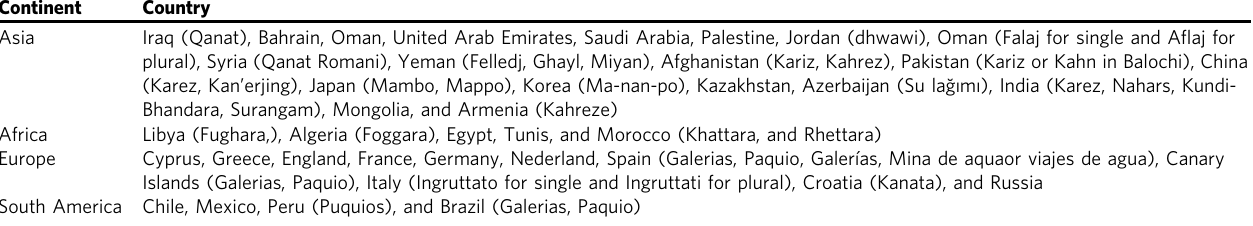
Table 4 The historical spread of qanat under different names (in parentheses). Continent